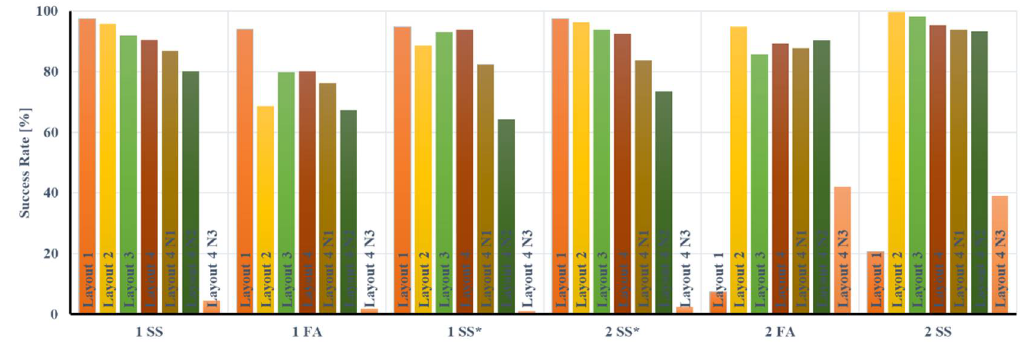
Figure 7. Success rate in percentage obtained with Layouts 1–4 and noise level for Layout 4 from N0 to N3 (Layouts 1 and 2, MAC limit of 0.5; Layouts 3 and 4N1 to 4N3, MAC limit of 0.8).